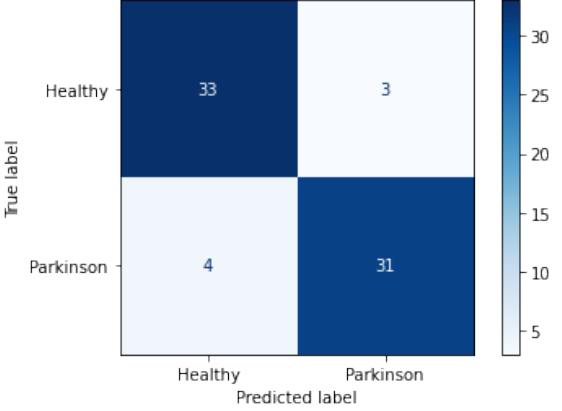
Figure 12. Confusion matrix for the validation